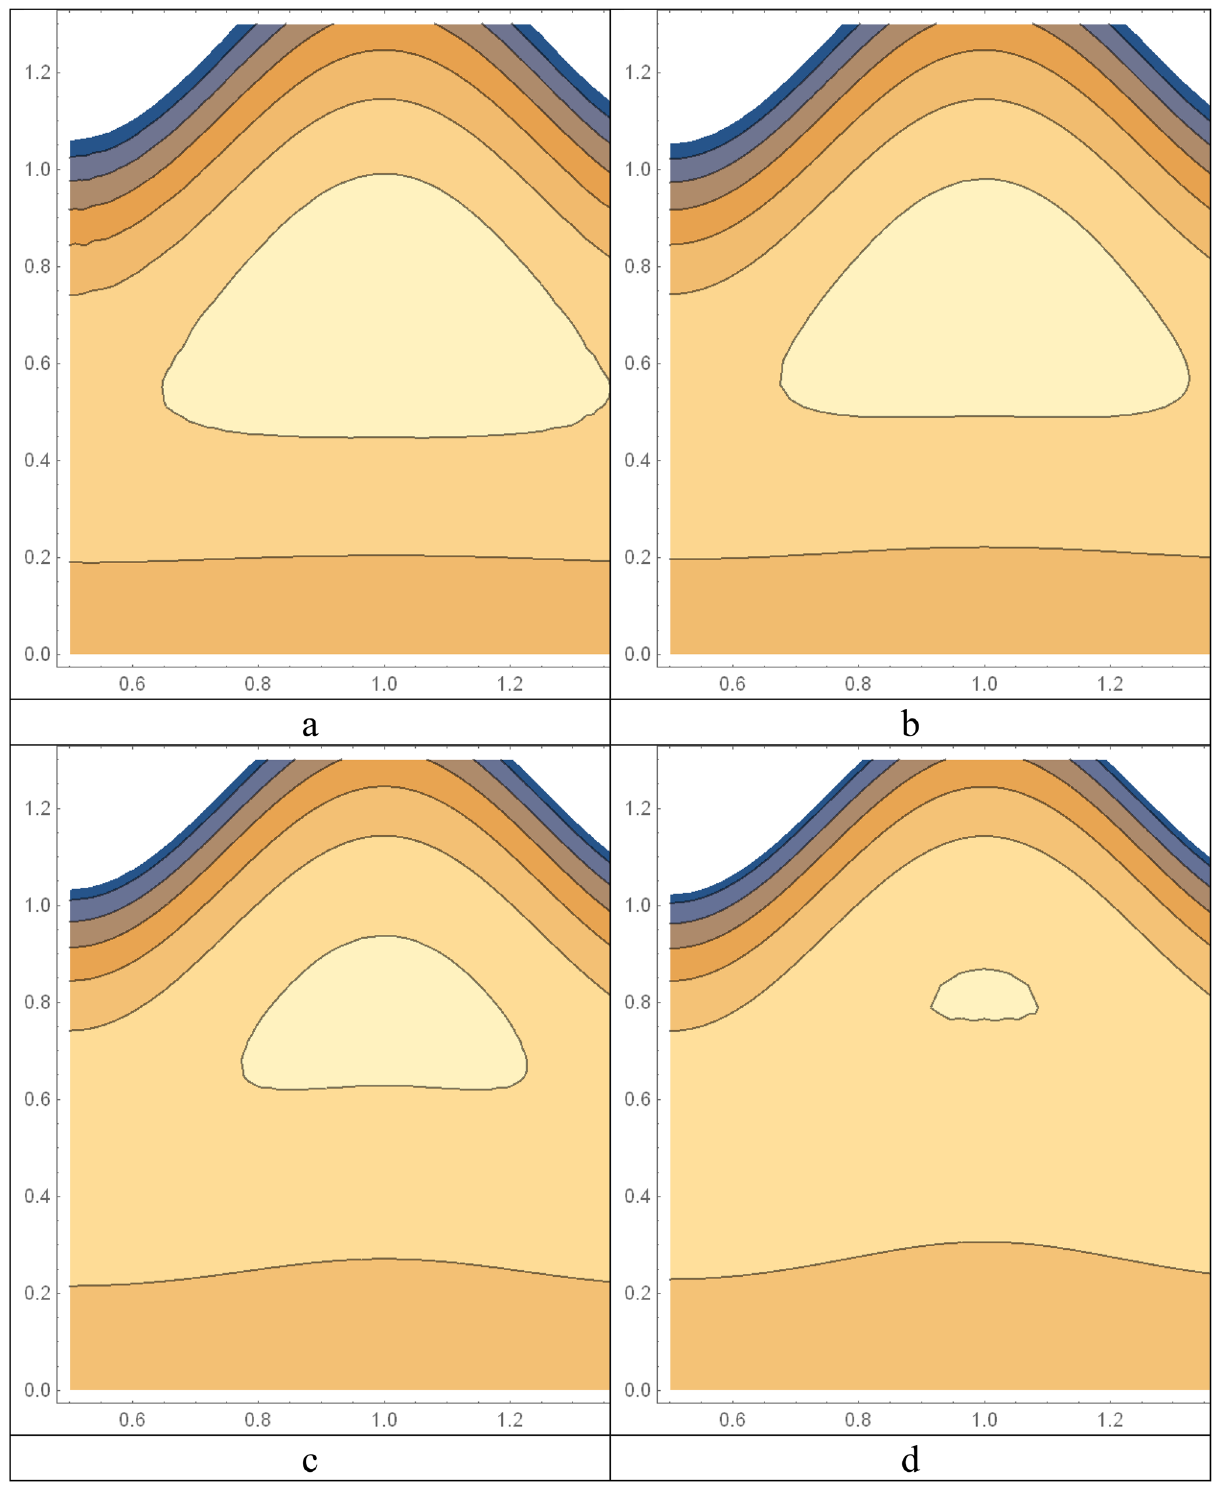
Figure 16. Streamlines for different M, ( a ) M = 0.01, ( b ) M = 1.0, ( c ) M = 2.0, ( d ) M =